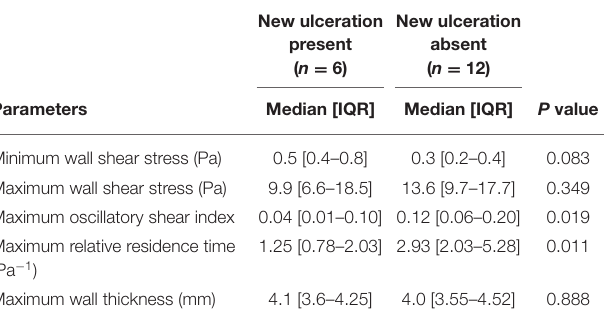
TABLE 2 | Wall shear stress and wall thickness in the symptomatic carotid artery with (cases) and without (controls) new ulcerations at